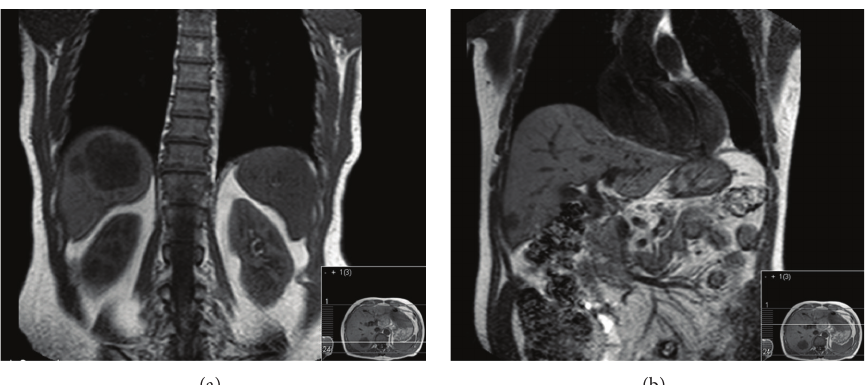
Figure 1: Synchronous liver metastases within right lobe of the liver. (a) Two lesions in segment VII measuring 43 mm and 14mm in diameter. (b) A lesion close to the surface of segment V measuring 16mm in